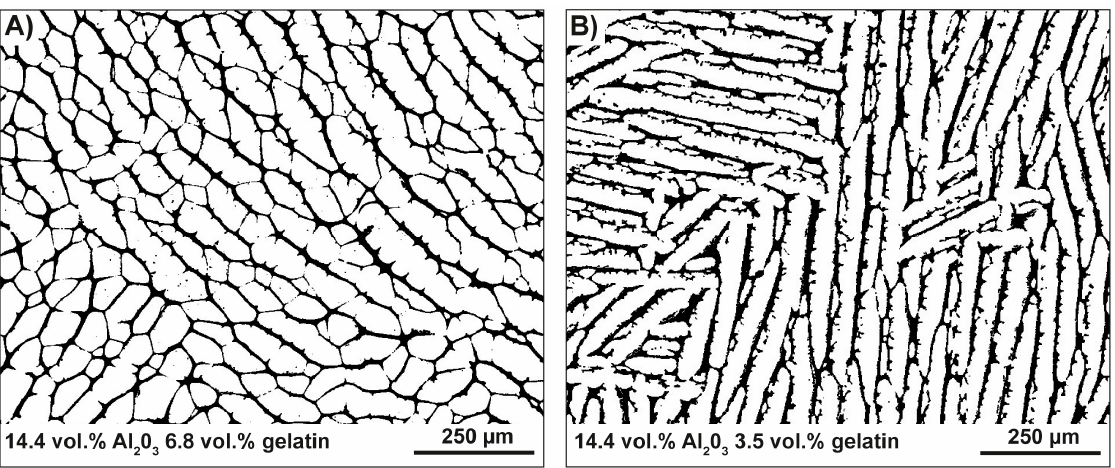
Figure 20. BSE images of the cross sections of the freeze-casted ceramics (perpendicular to the freezing-direction). The cavities of the ceramics were filled with epoxy resin (= white areas). Therefore, the varying degrees of interconnectivity of the struts in the ceramics is demonstrated in ( A , B ) depending on the gelatin concentration.